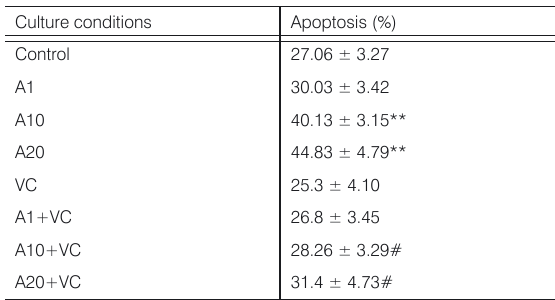
Figure 1. In vitro effect of amiodarone and vitamin C on 5CMF-DA fluorescence intensity (cellular glutathione content) in rat thymocytes.